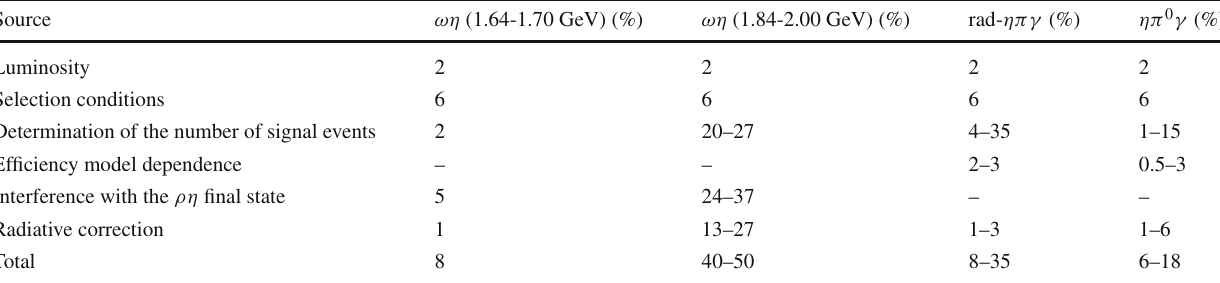
Table 1 The parameters obtained in the fits to the e + e − → ωη and e + e − → rad- ηπγ cross sections. B V = B ( V → e + e − ) B ( V → ωη) for ωη , and for rad- ηπγ . For the ωη final state the results for the two variants of the fit are listed in comparison with the results of the SND [8] and CMD-3 [7] experiments obtained in the ω → π + π − π 0 decay mode Table 2 The weighted average √ s ) for the interval energy ( indicated in parentheses, integrated luminosity ( L ), detection efficiency ( ε ωη ), number of selected events ( N ωη ), radiative correction (1 + δ ), and Born cross section ( σ ωη ) for the process e + e − → ωη → ηπ 0 γ . For the cross section, the first error is statistical, and the second is systematic